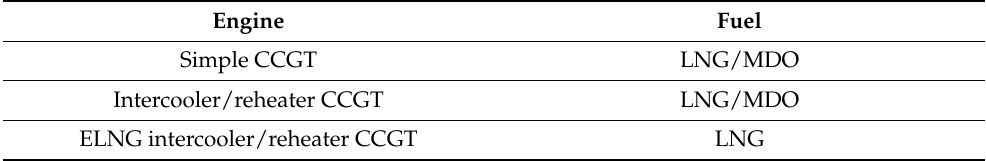
Table 1. CCGT engines and their corresponding fuels.